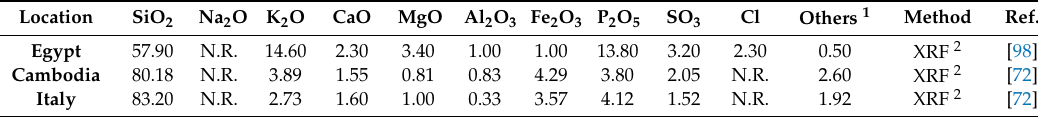
Table 2. Accompanying ash constituents of RH (wt % db) from different